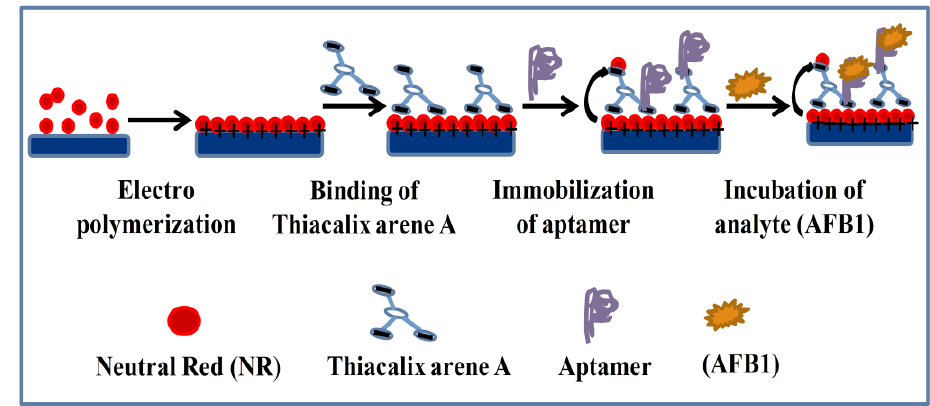
Figure 2. Schematic representation of an electrochemical aptasensor used for determination of AFB1 using electropolymerized modified electrodes (scheme illustration from [80]).